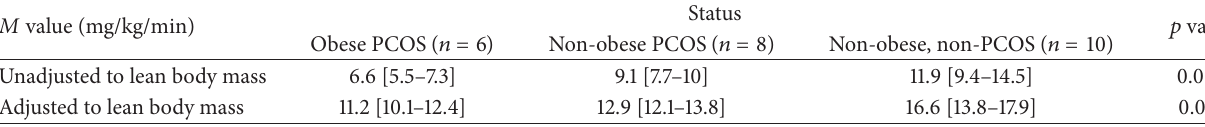
Table 3: Unadjusted and fat-free mass adjusted insulin sensitivity across subgroups.